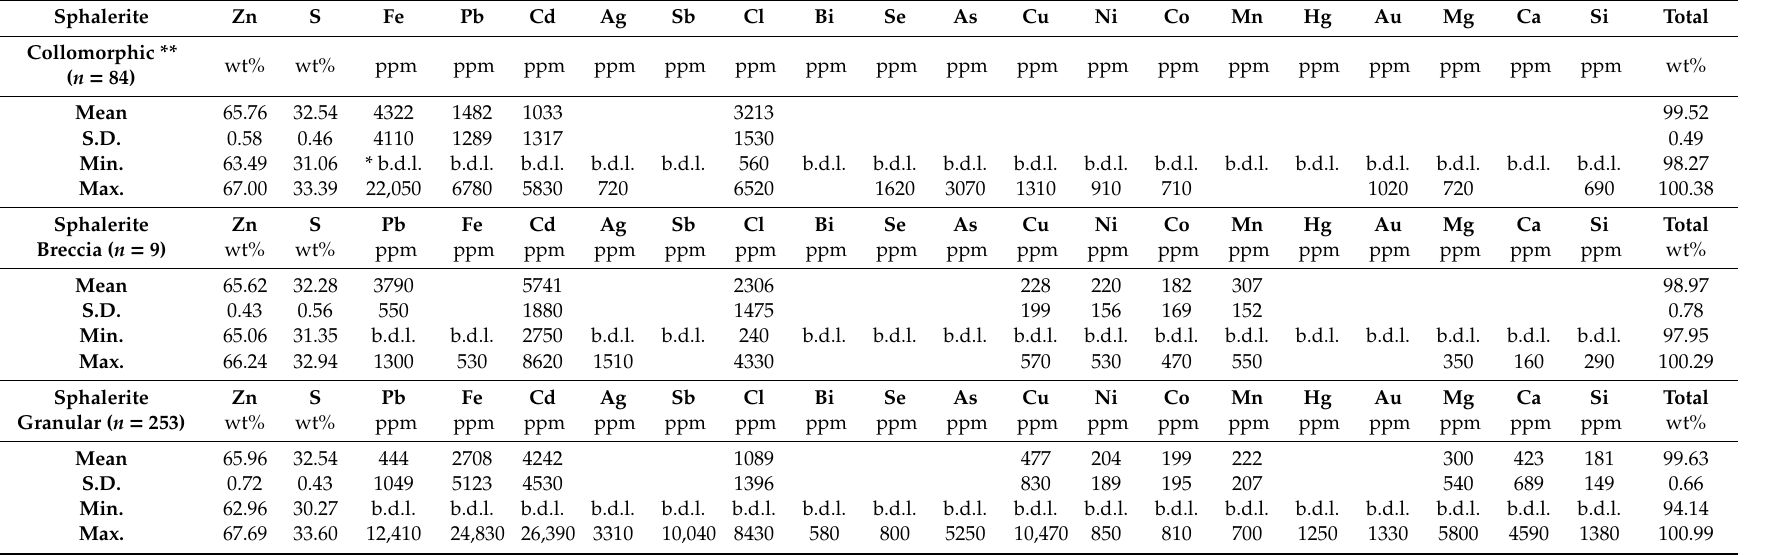
Table 5. Average EPMA analyses of di ff erent types of sphalerites from the main ore stage in the Zn-Pb (MVT) deposits in Poland. Sphalerite